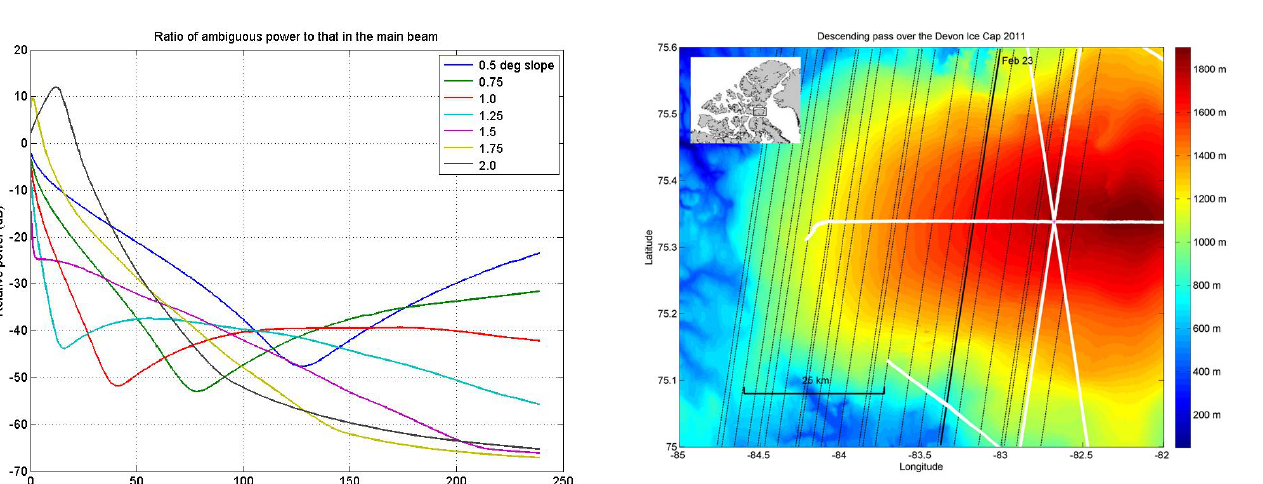
Figure 2 (bottom): The relative 2-way antenna gain is shown for cross-track cuts at 5 different fore angles corresponding to the central and the 8 th , 16 th , 24 th and 32 nd beam. These are the dashed lines while the solid blue line corresponds to the effective 2-way pattern1 2 2 ( ) way G   given in Eq. (6). Note that the cross-track angle extent in Fig. 2 (bottom) is much wider than that in Fig. 2 (top).